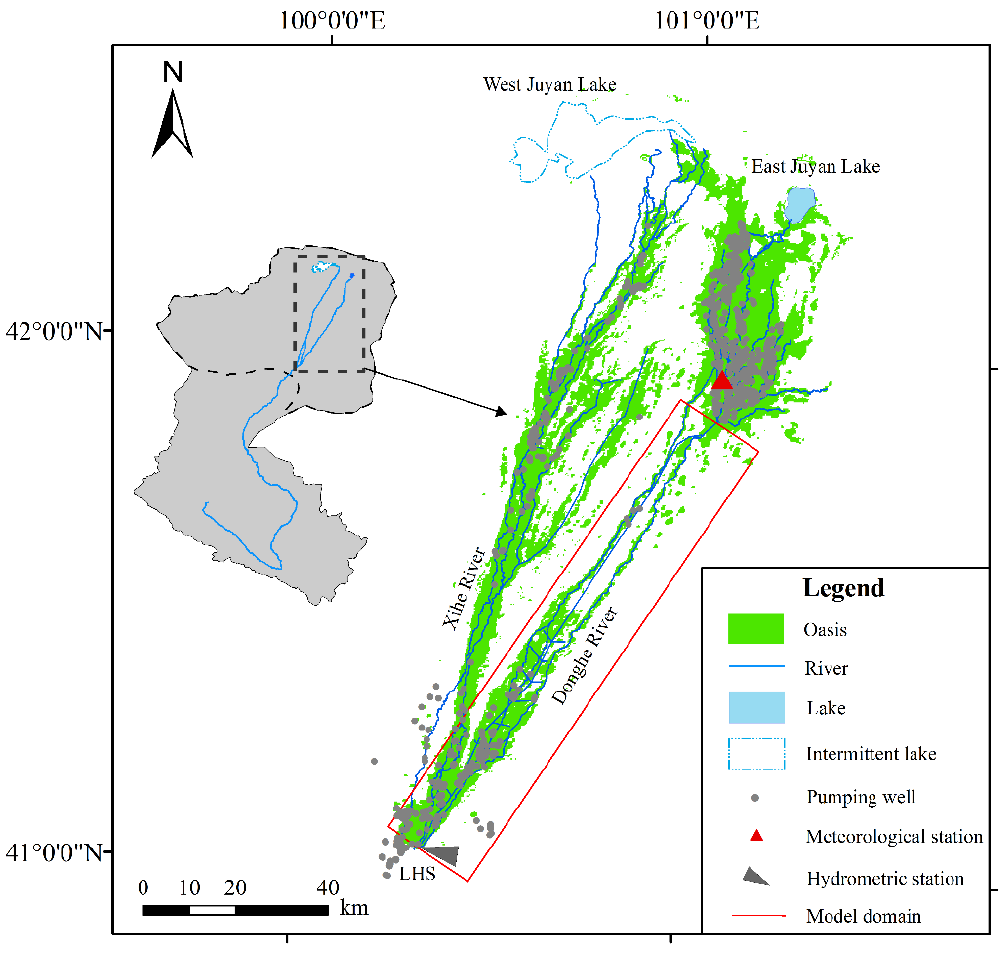
Figure 1. Study area and simulation domain. LHS represents the Langxinshan hydrometric station.